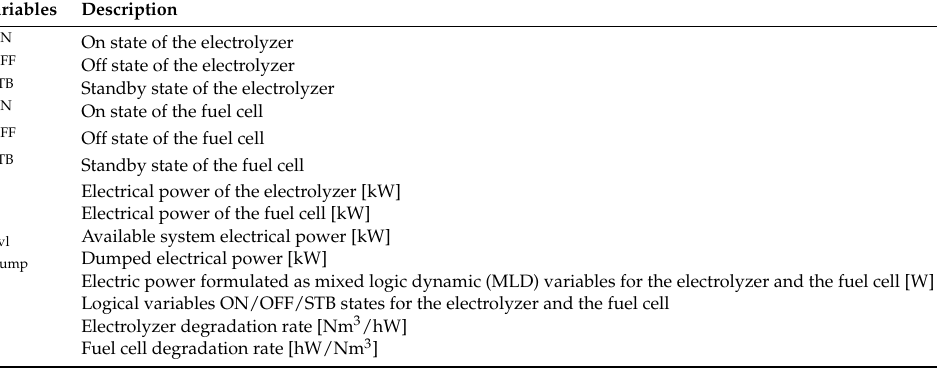
Table 3. Real and logical time varying